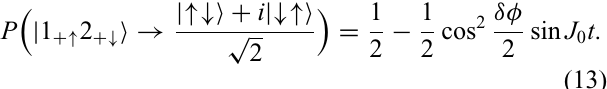
FIG. 2. The time evolution of the spin state given by Eq. (10) for t ranging from 0 to 2 π/ J 0 , plotted for different values of δφ . The x - y cross section of the Bloch sphere is shown since the path stays entirely within the x - y plane. These paths are independent of (cid:2) .